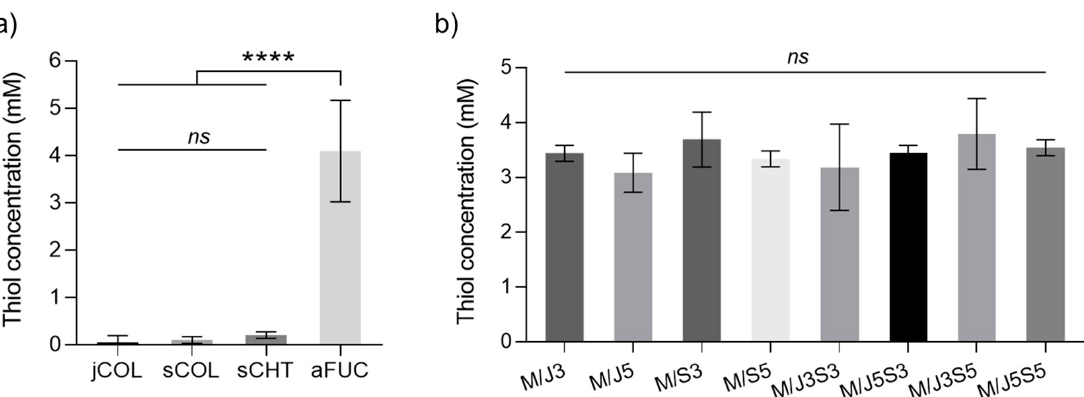
Figure 3. Determination of thiol (-SH) contents ( a ) determination on marine polymers (jCOL, sCOL, sCHT and aFUC), and ( b ) determination on the developed biomaterial-membranes (M/J3 to M/J5S5). Data bars are mean ± standard error (n = 3). The membrane samples do not show statistical differ- ences represented by ns (no significance) except those represented with the symbol **** ( p < 0.0001).